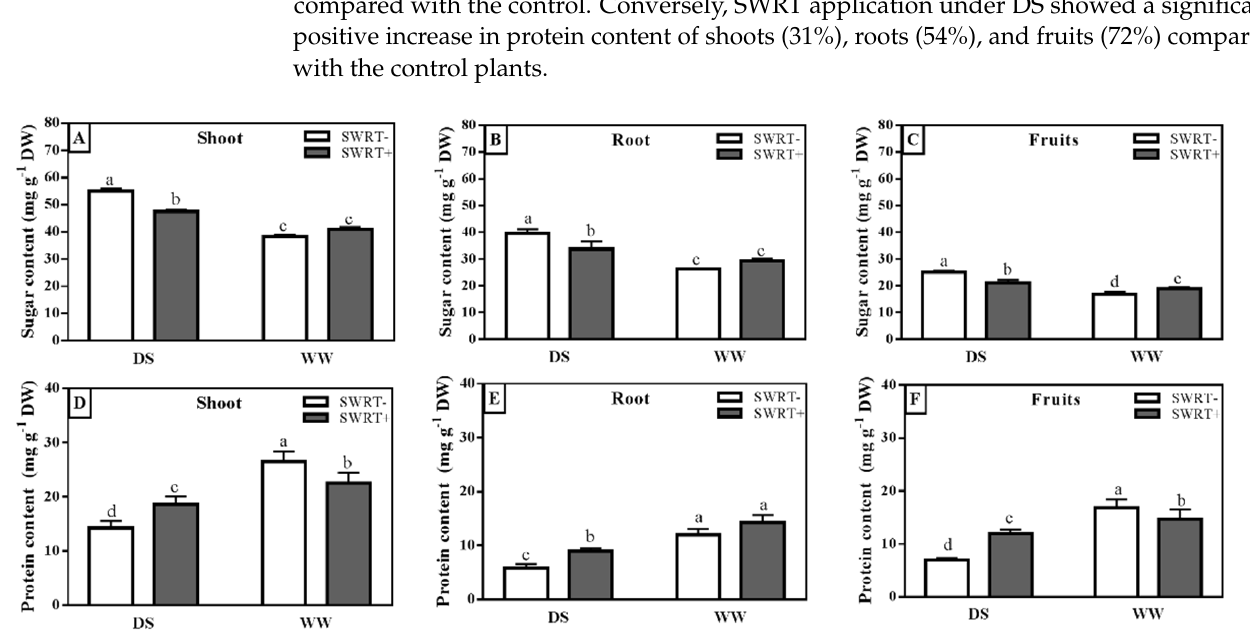
Figure 2. Effects of water regimes (DS: drought stress or WW: well-watered) on shoot and root ( A ) malondialdehyde (MDA) and ( B ) hydrogen peroxide (H 2 O 2 ) content subjected to treatments. SWRT − : without subsurface water retention technology (SWRT); SWRT+: with SWRT. Data